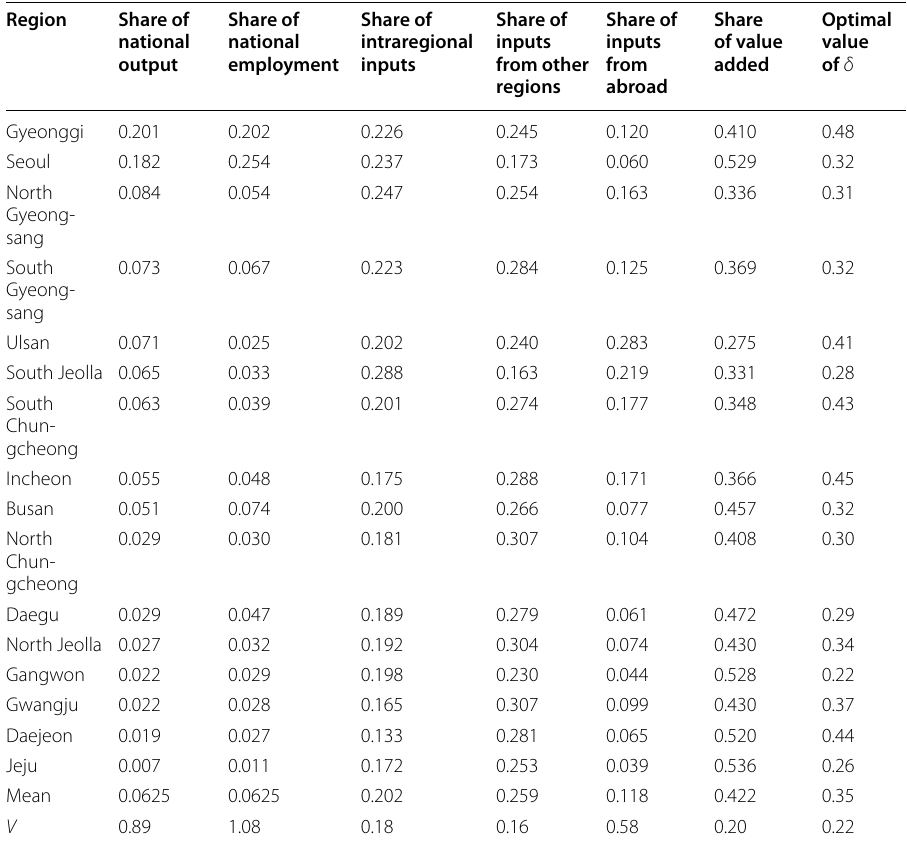
Table 3 Characteristics of South Korean regions in 2005. Source: adapted from Flegg and Tohmo (2019, table